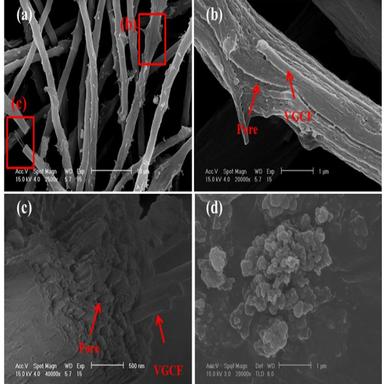
FE-SEM images of (a) SVF, (b) magnified section of SVF, (c) cross section of SVF, and (d) SP composites.